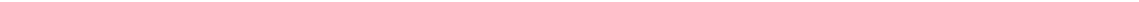
Fig. 1 Hook interacts with LIC1 via the N-terminal Hook domain. a Domain organization of Hook1 and constructs used in this study (CC: coiled-coil, CBD: cargo-binding domain). b SDS-PAGE (4 – 12%) showing several of the proteins used in this study. c SEC-MALS analysis of Hook1 constructs and MBP-LIC1 FL (color coded as indicated). The molar mass determined from light scattering (right y -axis) and the UV absorption at 280 nm (left y -axis) are plotted as a function of the elution volume. The theoretical masses are given in parenthesis. d – g ITC titrations of LIC1 and Hook1 constructs as indicated. Listed with each titration are the concentrations of the protein in the syringe and in the cell, as well as the temperature of the experiment and parameters of the fi t (stoichiometry N , dissociation constant K D ). Errors correspond to the s.d. of the fi ts. Open symbols correspond to titrations into buffer (except part e , where both titrations are into buffer). h Representative rotary shadowing EM image of Hook1 FL . Scale bar, 100 nm. White squares indicate individual Hook1 FL molecules highlighted in the zooms shown on the right. Scale bar, 50 nm. i Close-up view of a representative Hook1 FL molecule shown alongside a cartoon representation of the Hook1 domains based on the rotary shadowing EM, secondary structure and sequence conservation analyses (see Supplementary Fig. 1). Scale bar, 50 nm. j Length distribution of the region spanning from the end of the neck to the kink. Bin size, 5 nm, n =